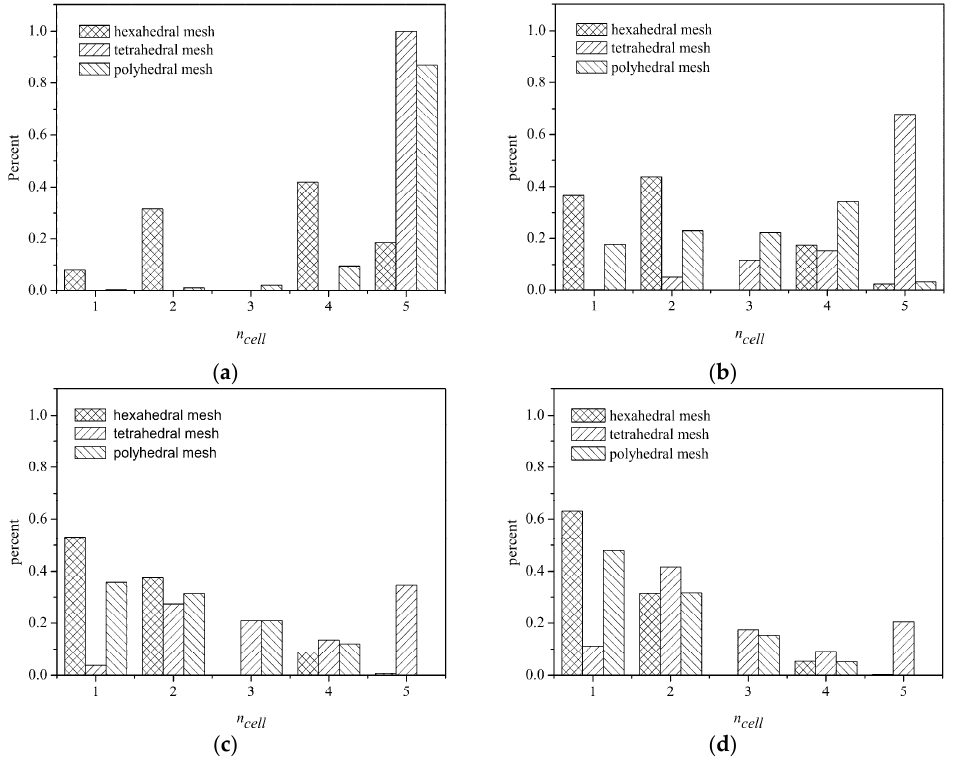
Figure 11. The percentage of background cubes covered by a given number of computational cells. ( a ) Background grid with 100 3 cells; ( b ) Background grid with 200 3 cells; ( c ) Background grid with 300 3 cells; ( d ) Background grid with 400 3 cells.